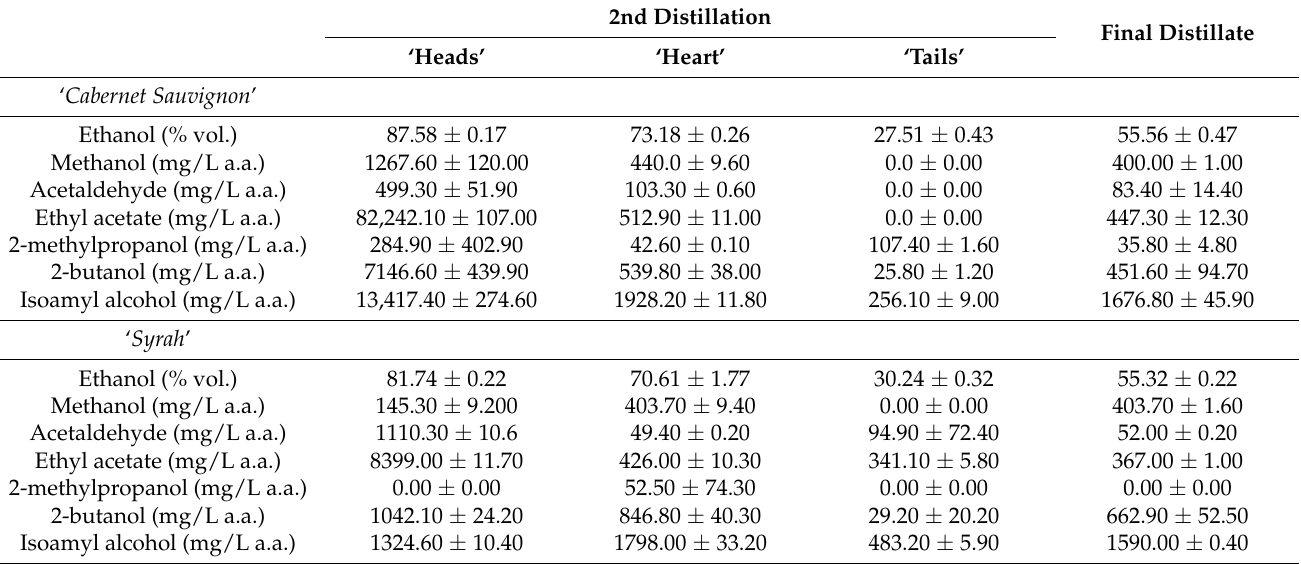
Table 7. Primary volatile compounds identified in different fractions of 2nd distillation and in final ‘ Cabernet Sauvignon ’ and ‘ Syrah ’ distillate.